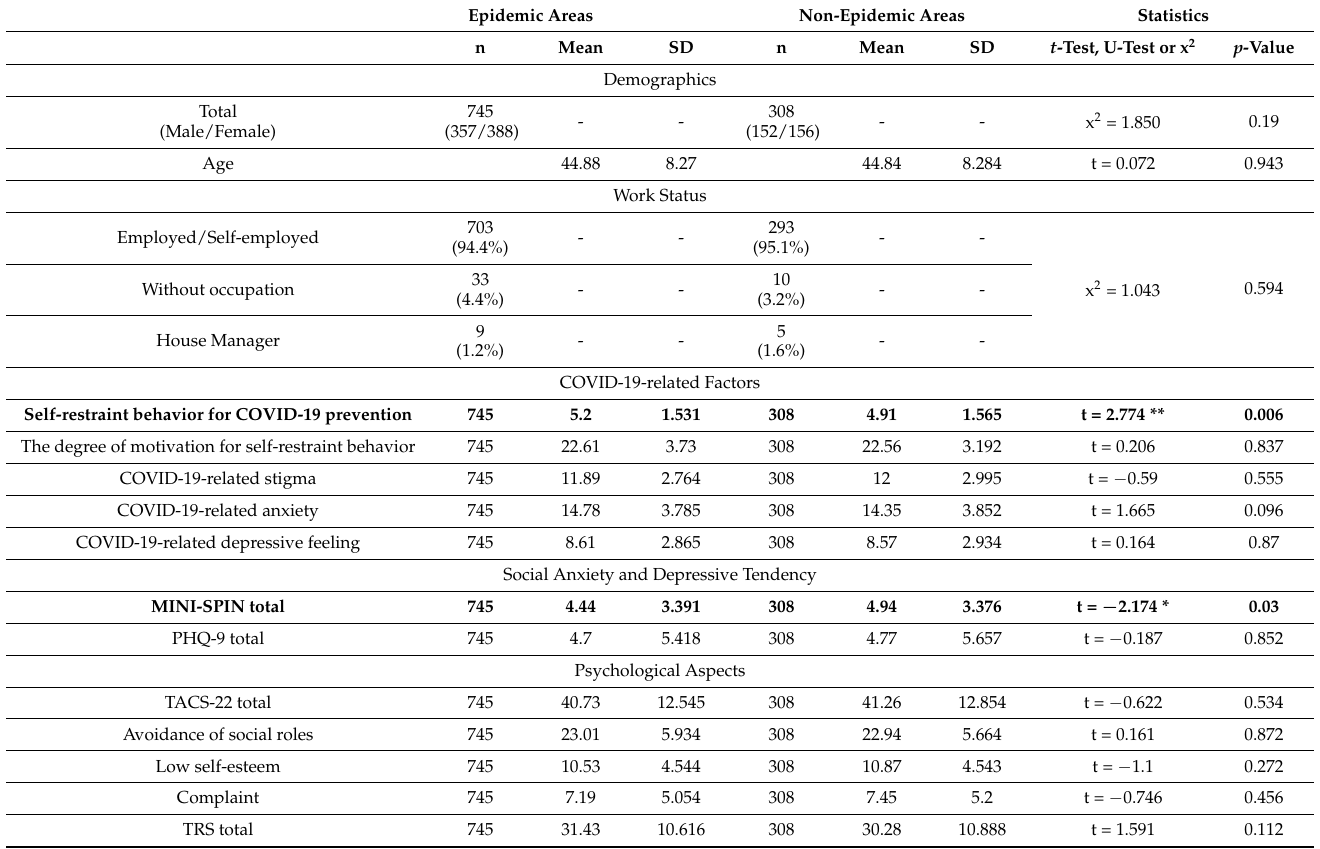
Table 2. Comparisons of epidemic areas and non-epidemic areas ( n =